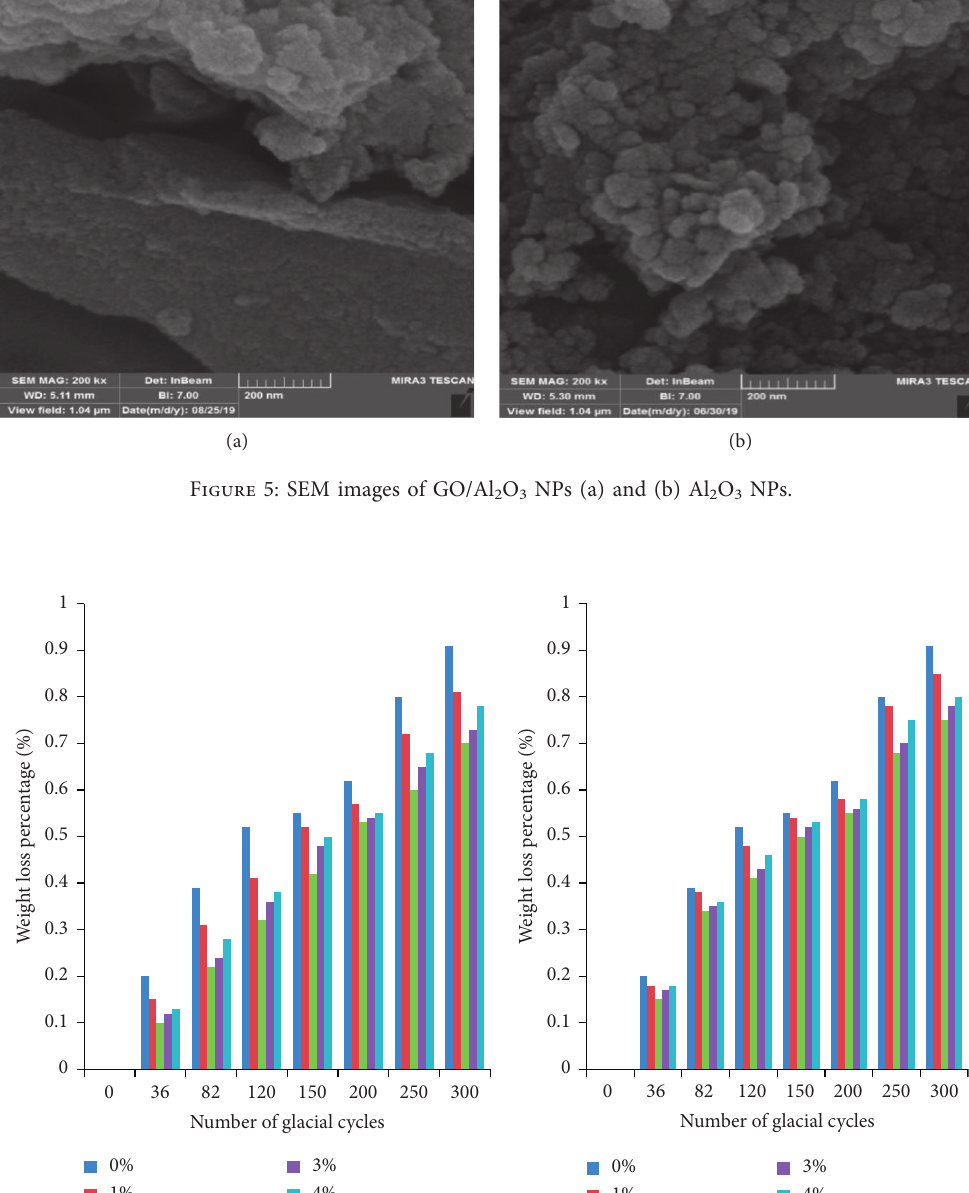
2 O 3 nanoparticles and (b) Al 2 O 3